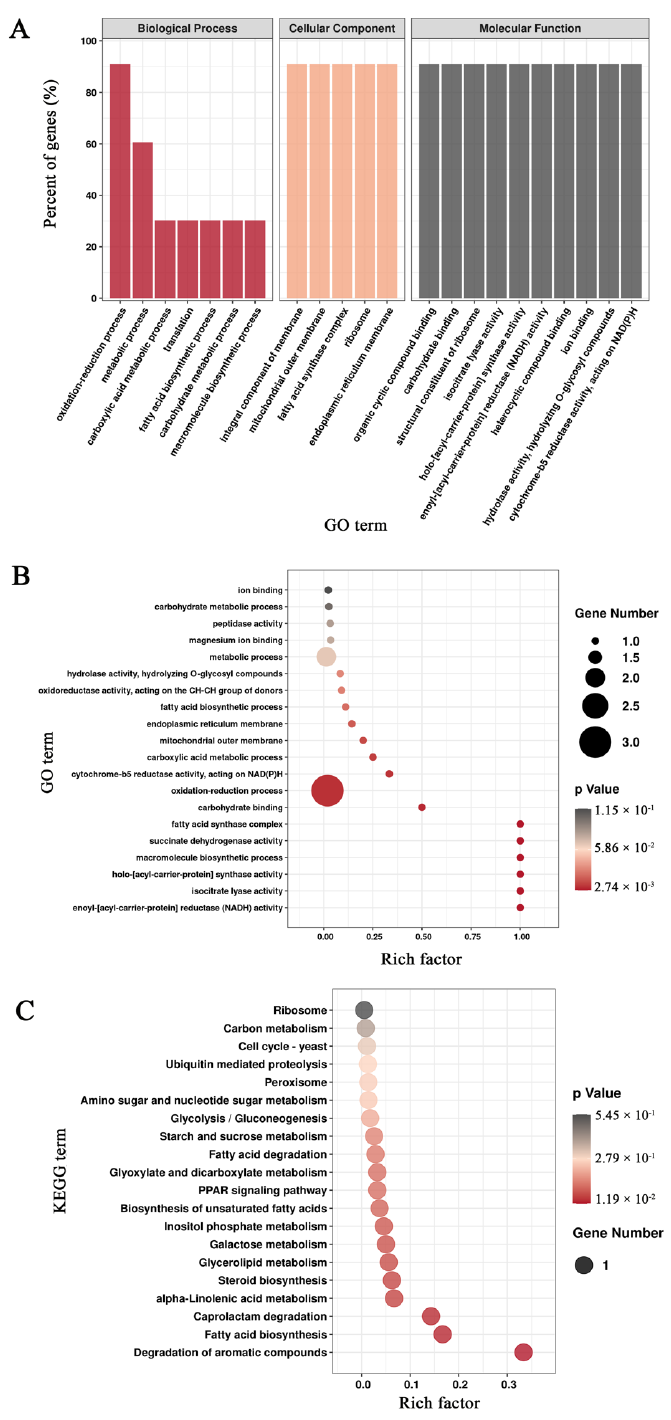
Figure 9. GO ( A , B ) and KEGG ( C ) enrichment analysis of differentially expressed genes (DEGs) shared among the three pairwise comparisons (i.e., TA vs. TB vs. TC) of the three groups of Mortierella alpina